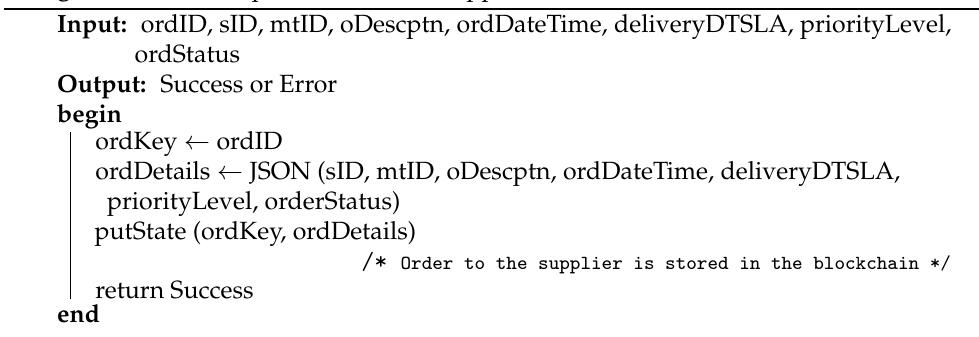
Algorithm 3: Order placement to the